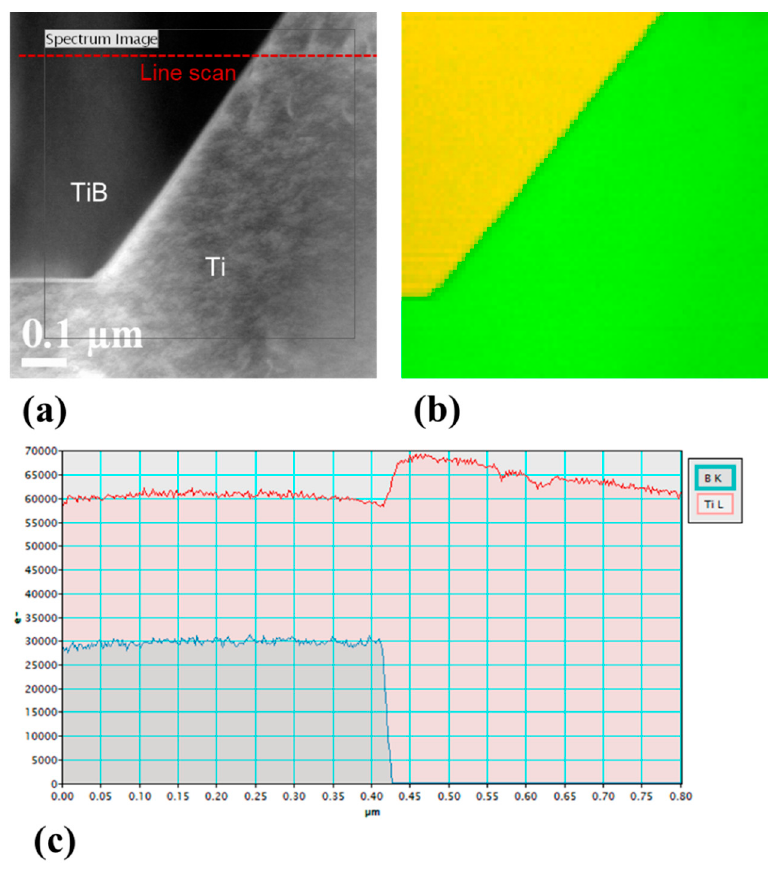
Figure 5. ( a ) Transmission electron microscopy (TEM) image taken from the enclosed dashed region highlighted in Figure 4. ( b ) High ‐ resolution TEM image featuring a Ti–TiB interface in the material shows a coherent Ti–TiB boundary in the material, taken from the enclosed dashed rectangle region highlighted in ( a ).